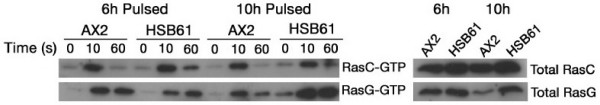
RasC and RasG activation in HSB61 mutant. AX2 or HSB61 cells were pulsed with cAMP for the time indicated, concentrated ten times, treated with cAMP and immediately lysed. The lysates were incubated with GST-Byr2 (RBD) as described in Material and Methods. The precipitate was subjected to electrophoresis and Western blot and hybridized with antibodies against RasC or RasG. Time (in seconds) after cAMP treatment is indicated. Total RasC and RasG in cell lysates from AX2 or HSB61 are shown on the right.